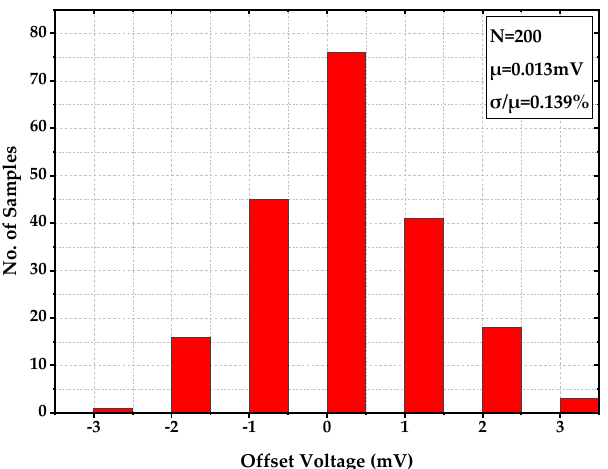
Figure 9. Offset Voltage of Op-Amp with 200-Sample Monte-Carlo Simulation.